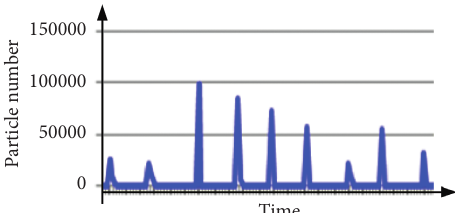
Figure 9: Number of particles generated by the absorbing glass with 351nm pulse at 1J/cm 2 . Under the action of 1J/cm 2 stray light of the absorbing glass, the number of particles larger than 0.1 μ m will deteriorate to 100000.